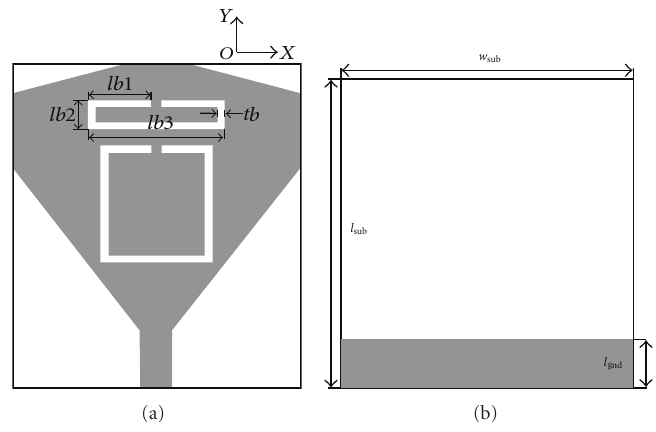
Figure 3: Geometry of dual band-notched antenna. (a) Top view, (b) bottom view.